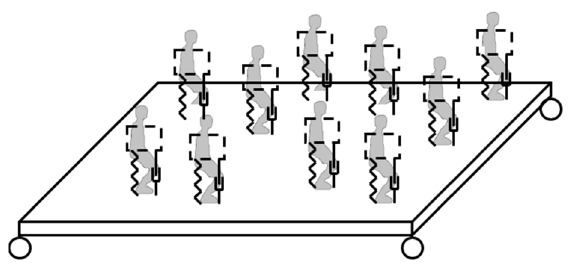
Figure 2. Diagram of analytical model for crowd bouncing.